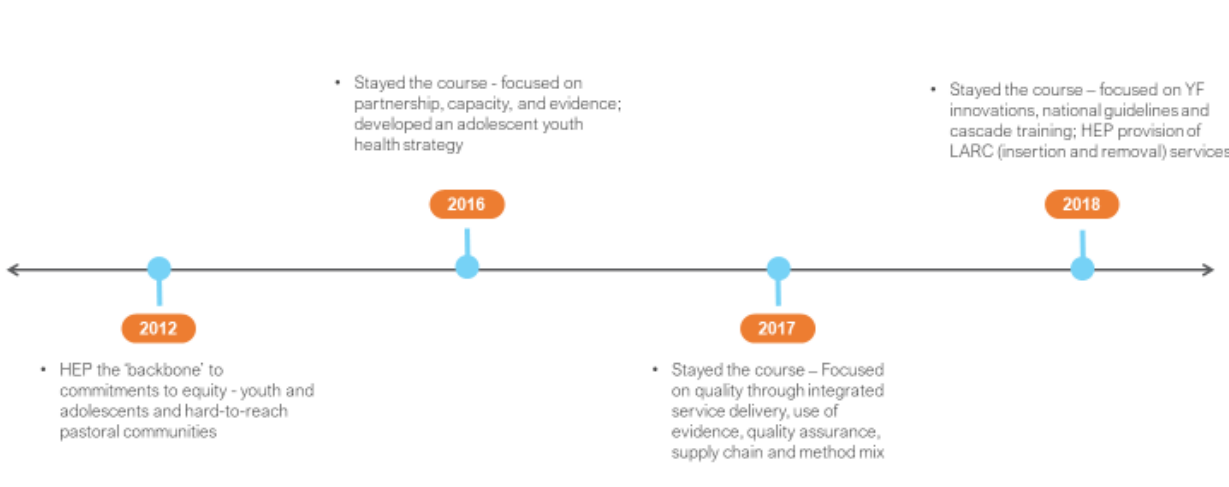
Figure 5. Ethiopia FP2020 commitments and timeline. HEP – Health Extension Programme; LARC – long acting reversible